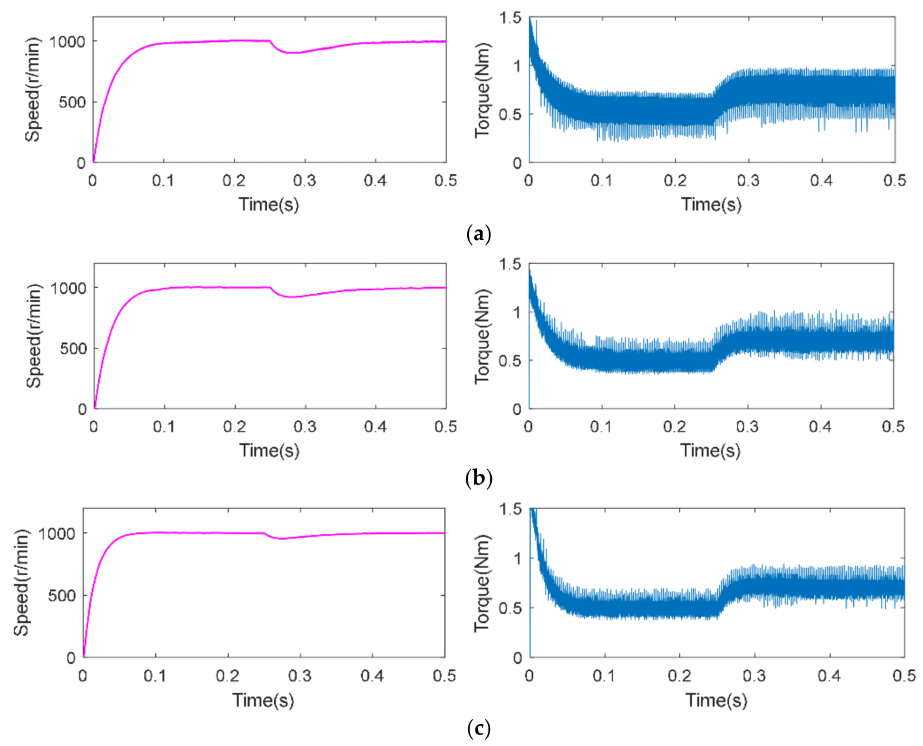
Figure 11. Speed and torque under load torque change. ( a ) Method 1, ( b ) method 2, and ( c ) method